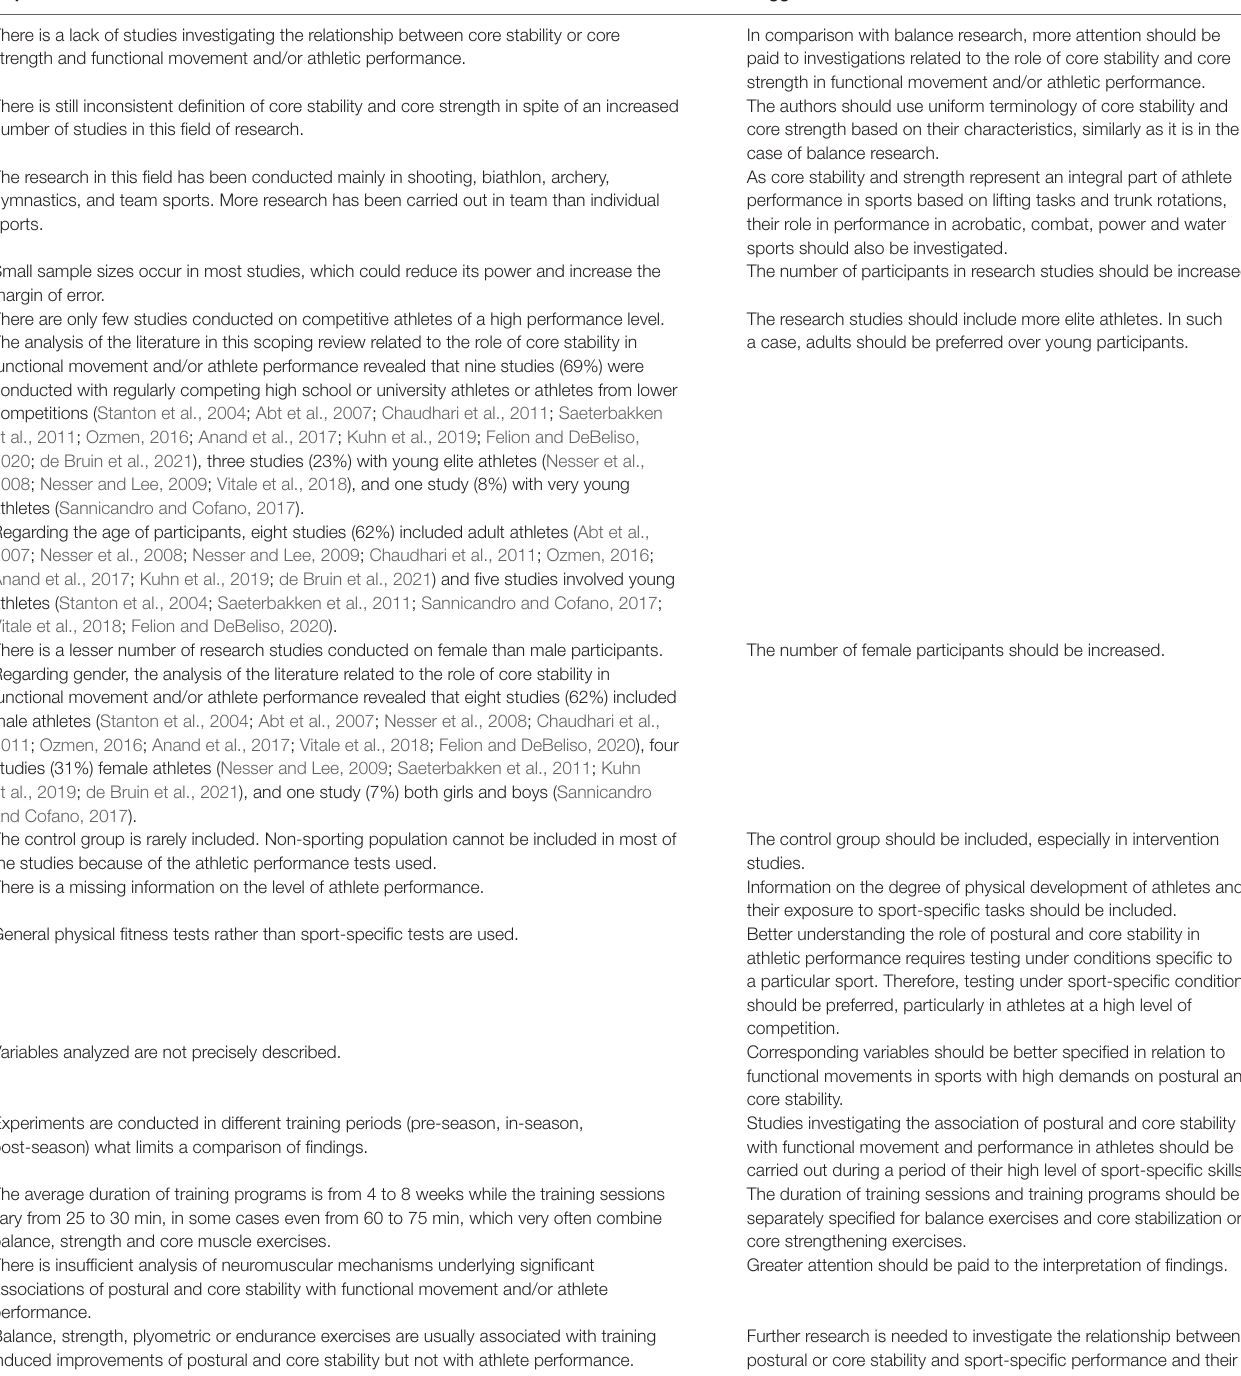
TABLE 3 | Research gaps identified in the literature and suggestions for future